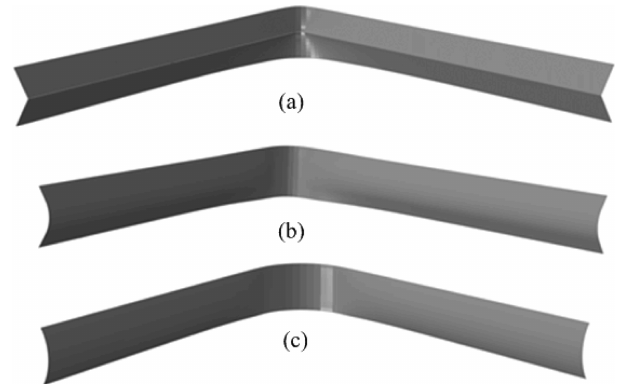
Figure 11. Typical deformed shapes of different strips in the fi- nite element modellings by using bilinear material model with the tangent modulus E tan = 65500MPa: (a) strip with r = 0mm and b = 10mm, (b) strip with r = 10mm and b = 4 . 82mm, and (c) strip with r = 19 . 2mm, b =